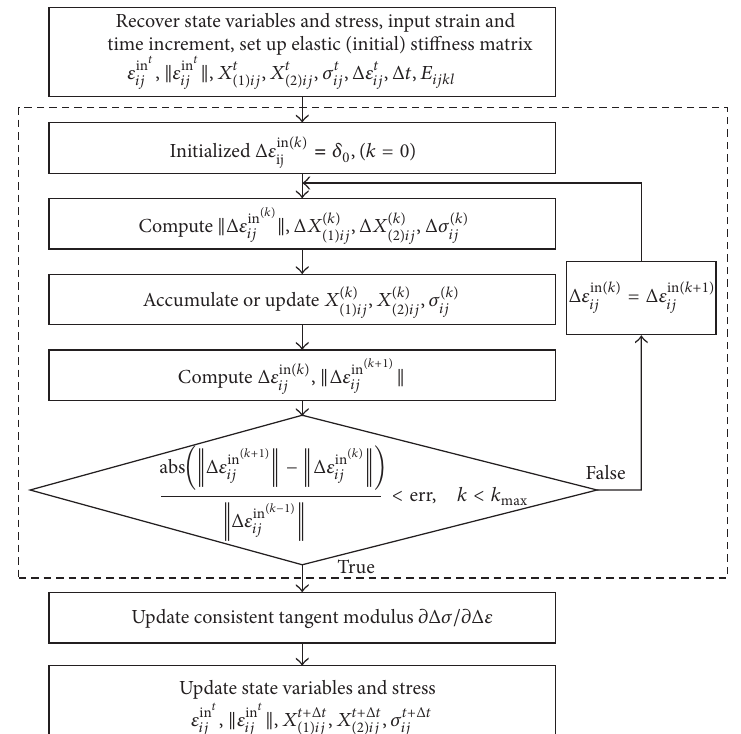
Figure 2: Analysis flow chart of a cyclic softening